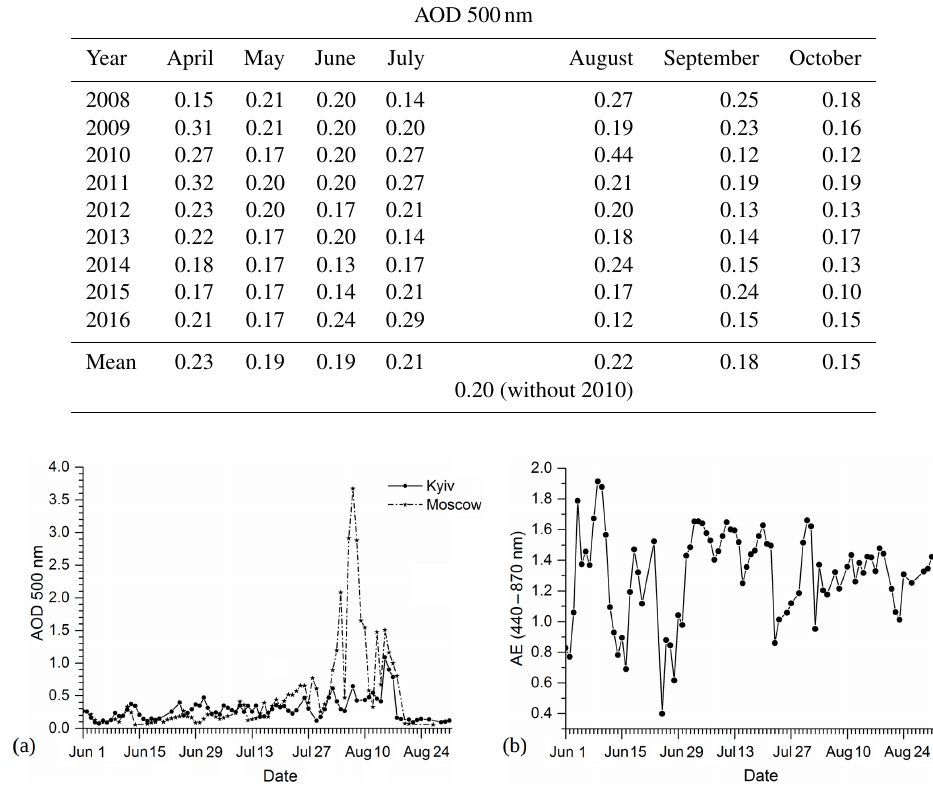
Table 2. Annual changes of monthly averaged AOD 500nm over Kyiv during the warm season for the available period from AERONET observations.